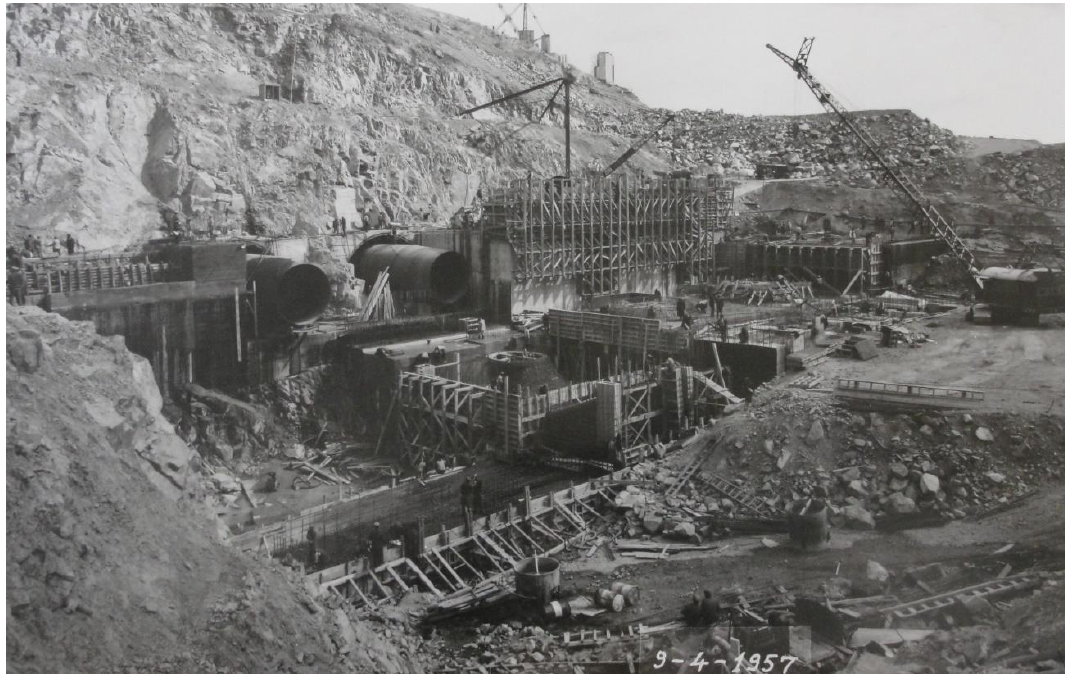
Figure 1. Construction of Hirfanlı Dam—Turkey [3].